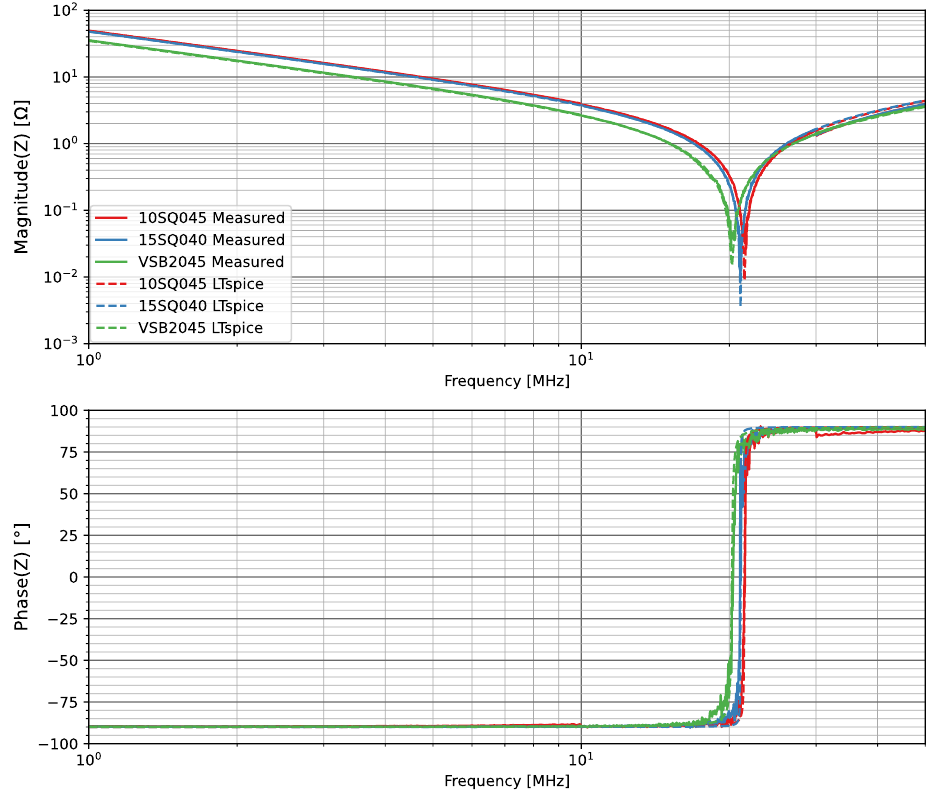
Figure 25. Measured and simulated magnitude and phase plots of the three diodes between 1MHz and